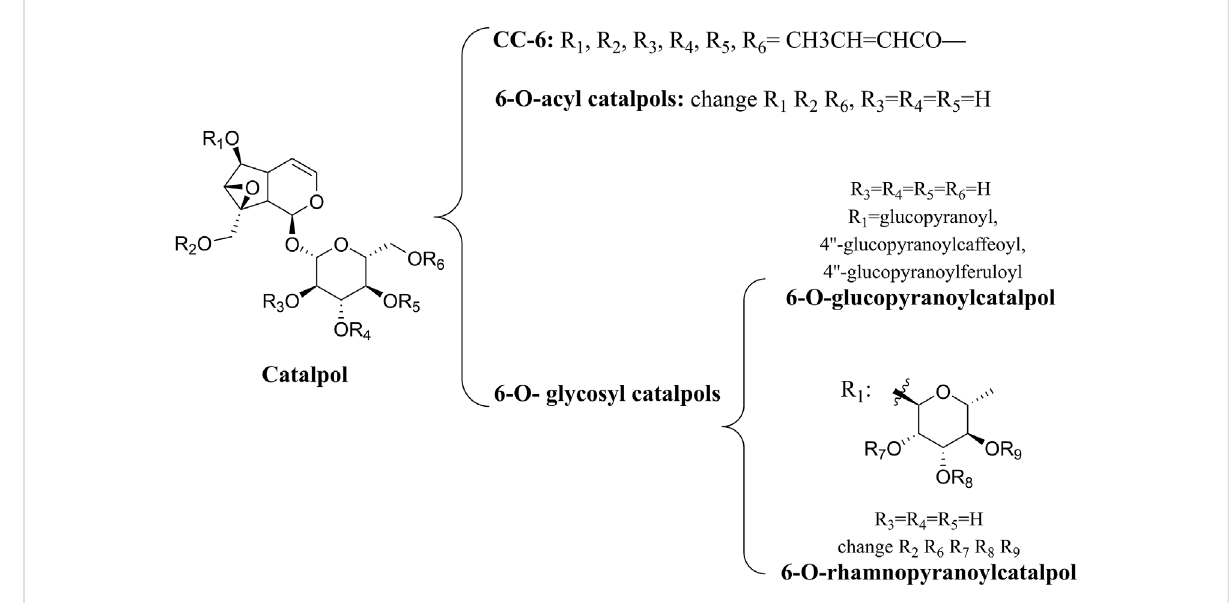
FIGURE 2 Catalpol and its